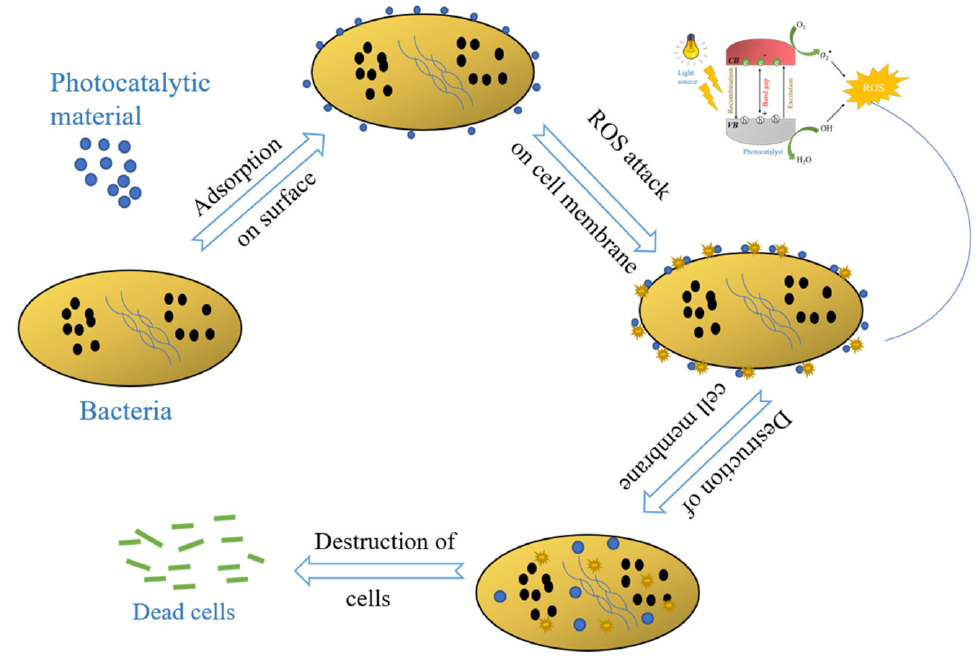
Figure 3. A schematic demonstrating various steps involved in photocatalytic bacterial